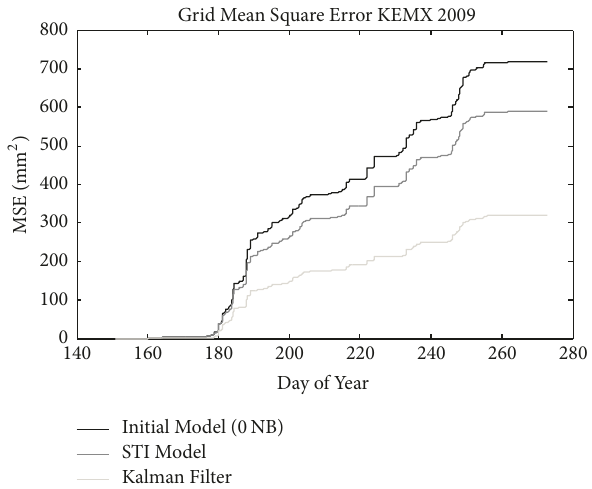
Figure 2: Cumulative total domain Mean Squared Error: simple linear model, STI model, and Kalman filter, from